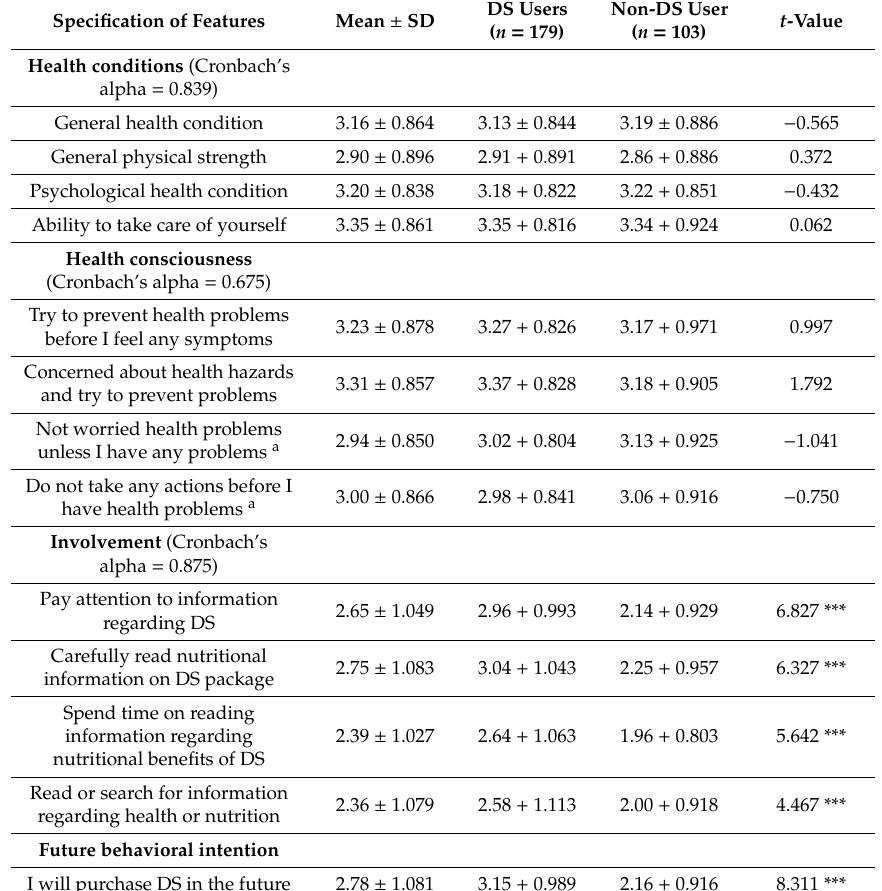
Table 3. Comparisons of DS users and non-users of health conditions, consciousness, involvement, and future behavioral intention toward